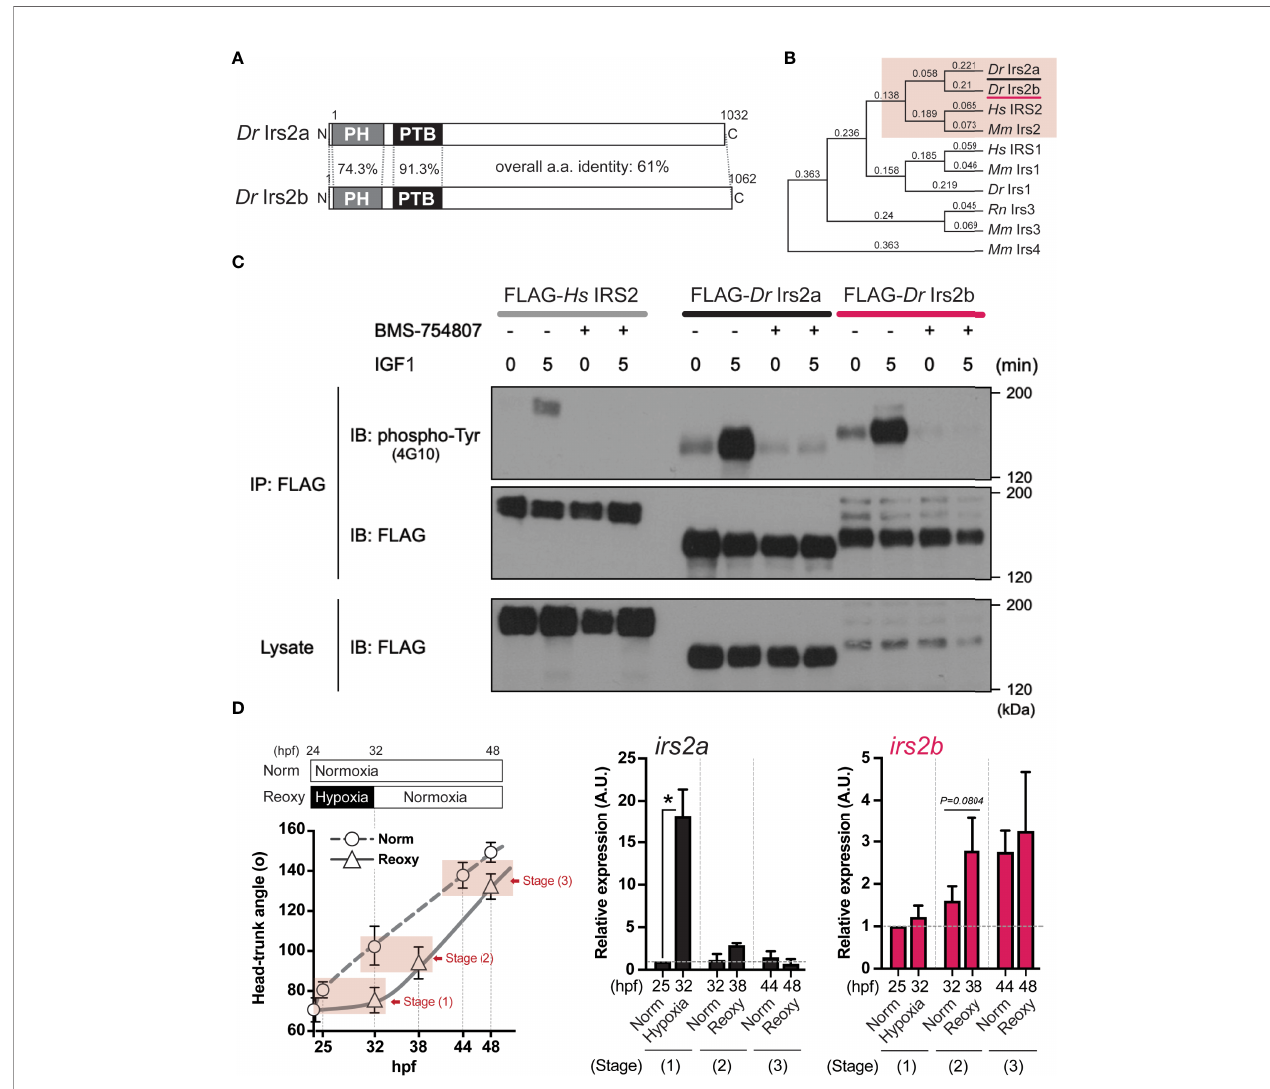
FIGURE 5 | Identi fi cation, characterization, and expression of two zebra fi sh Irs2 genes ( irs2a/b ). (A) Schematic illustration of zebra fi sh Irs2 proteins ( Dr Irs2a/2b). Characteristic pleckstrin homology (PH) domain and IRS-type phospho-tyrosine binding (PTB) domain are shown. (B) Phylogenetic analysis of the deduced amino acid sequence of Irs/IRS molecules based on the Neighbor joining method with bootstrap proportions. Dr , Danio rerio ; Hs , Homo sapiens ; Mm , Mus musculus ; Rn , Rattus norvegicus. (C) Functional assay of zebra fi sh Irs2s in HEK293T cells. FLAG-tagged human IRS2 and zebra fi sh Irs2a/b were expressed, and the cells were treated with or without the speci fi c IR/IGF-1R tyrosine kinase inhibitor BMS-754807 and were stimulated with IGF1 (100 ng/mL) for 5 minutes. Immunoprecipitation (IP) and immunoblot (IB) analyses were performed using denoted antibodies. (D) Real-time Q-PCR analysis of irs2a/b expression during zebra fi sh embryogenesis. Data are average ± SD, n=8-38. The sampling timing and the outline of experimental design are shown in the left. Embryos harboring statistically comparable body size was applied for the gene expression comparison:stage(1), 25 hpf Norm vs32 hpf Hypo; stage (2) 32 hpf Normvs38 hpf Reoxy;stage (3), 44 hpf Norm vs 48 hpf Reoxy.TotalRNA originating fromwholeembryos was used for cDNA synthesis, and the house-keepinggene ( b -actin) expression was used for theinternal control and normalization.The data are shownas ± SE of 3 independent assays. The Norm 25 hpf groupisset as 1.0. The asterisk (*) denotes statistical difference at P<0.05